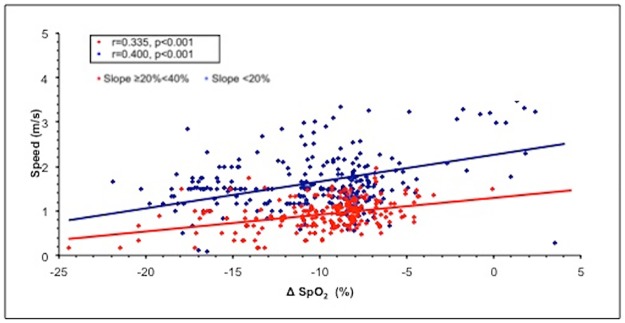
Relationship between mean horizontal speed and mean decreases in oxygen saturation during the run.To simplify the analysis, the slopes were grouped into two ranges: <20% and ≥20%. Abbreviation: SpO2, oxygen saturation.